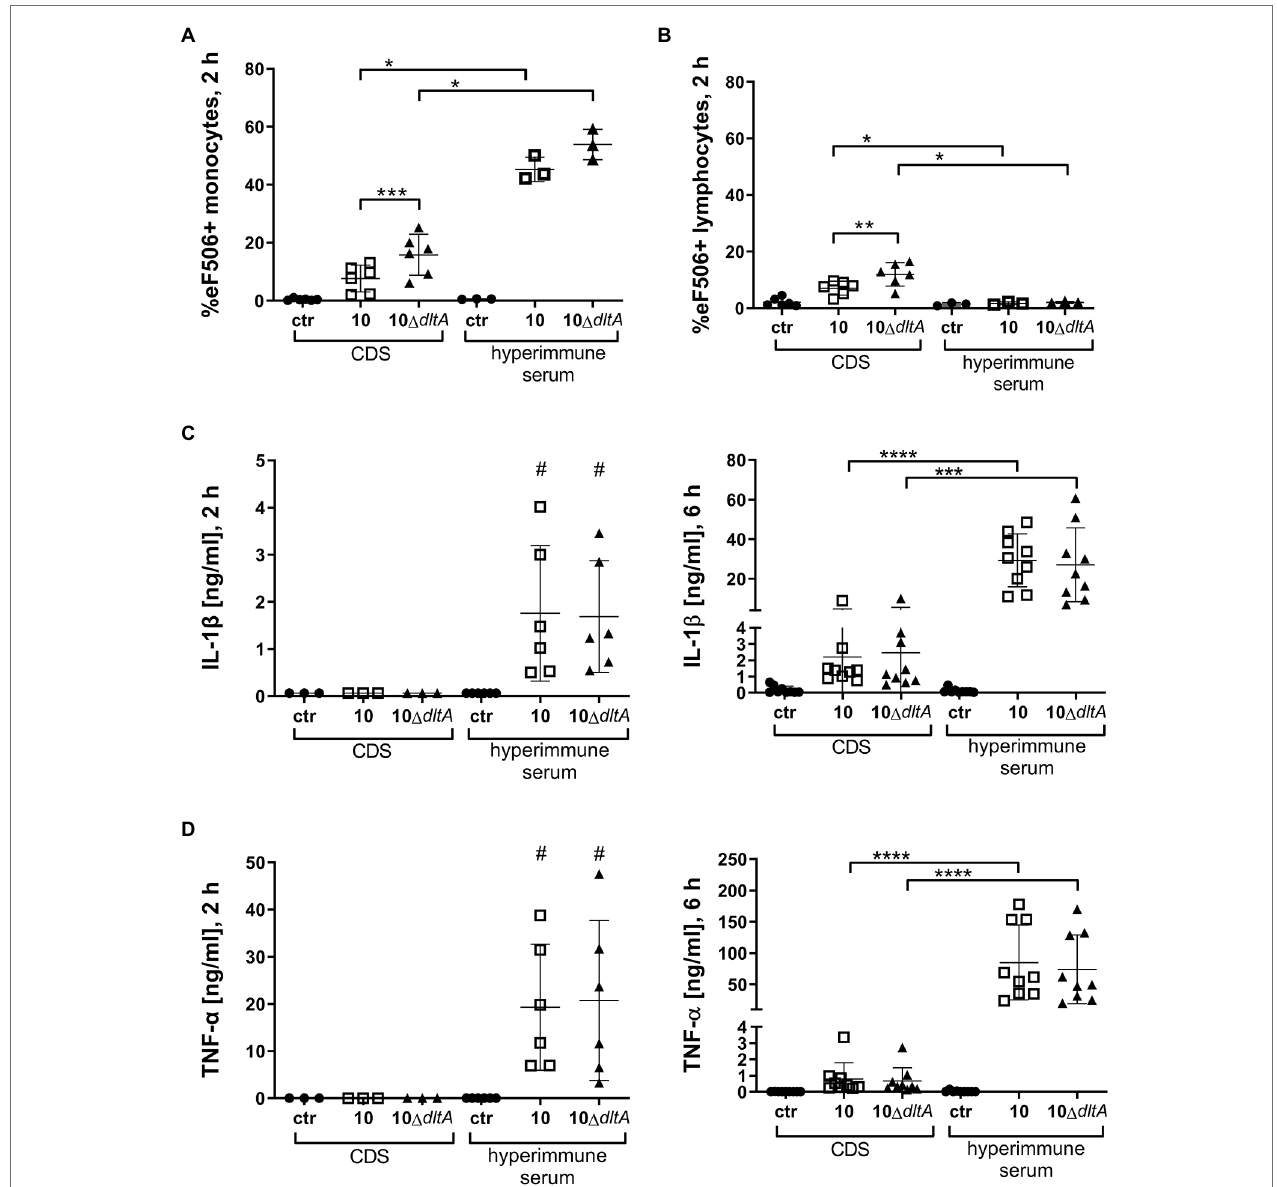
FIGURE 4 | Infection of PBMCs with Streptococcus suis opsonized in hyperimmune serum induces membrane damage in monocytes but not in lymphocytes and results in induction of IL-1 β and tumor necrosis factor (TNF)- α . For (A,B) , a subset of PBMC samples visualized in Figure 3 ( n = 6 for CDS and n = 3 for hyperimmune serum) were stained with the viability dye eFlour ™ 506 after 2 h of incubation with the respective S. suis strains. PBMC samples without bacteria served as negative control while heat-treated PBMCs served as a positive control (not shown: eF506+ monocytes 90.9%; eF506+ lymphocytes 89.6%). Samples were measured by flow cytometry. Results for monocytes are visualized in (A) , while lymphocytes are depicted in (B) . Pro-inflammatory cytokines IL-1 β (C) and TNF- α (D) were measured by ELISA in the supernatant of PBMC samples visualized in Figure 3 after 2 and 6 h of infection with respective S. suis strains. The limit of detection was 0.031 ng/ml for TNF- α and 0.063 ng/ml for IL-1 β . Horizontal lines and error bars represent mean values and SDs. For statistical analysis, paired t -test (wt vs. mutant) or unpaired t -test (CDS vs. hyperimmune samples) was performed. In case of not normally distributed samples (C,D) , Wilcoxon test or Mann–Whitney test was used, respectively. One sample Wilcoxon was performed to evaluate how much IL-1 β and TNF- α levels differ from the values 0.063 or 0.031 ng/ml, respectively, after 2 h of incubating PBMCs with S. suis opsonized in hyperimmune serum (all other values in this setting lay below the detection limit; #). * /# p < 0.05, ** p < 0.01, *** p < 0.001, and **** p <